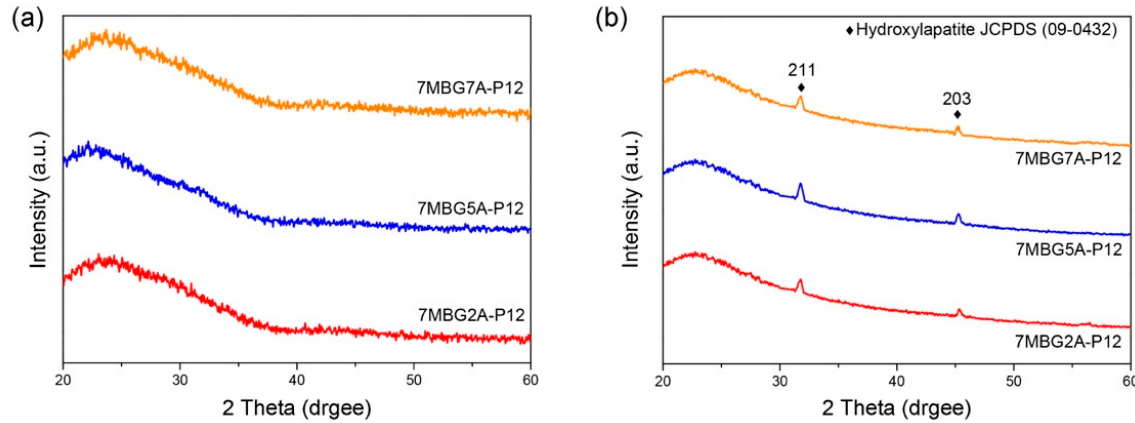
Figure 7. XRD patterns of MBG adding different concentrations of CH 3 COOH ( a ), and the bioactivity analysis results (XRD patterns) of MBG immersed in SBF for 24 h ( b ).